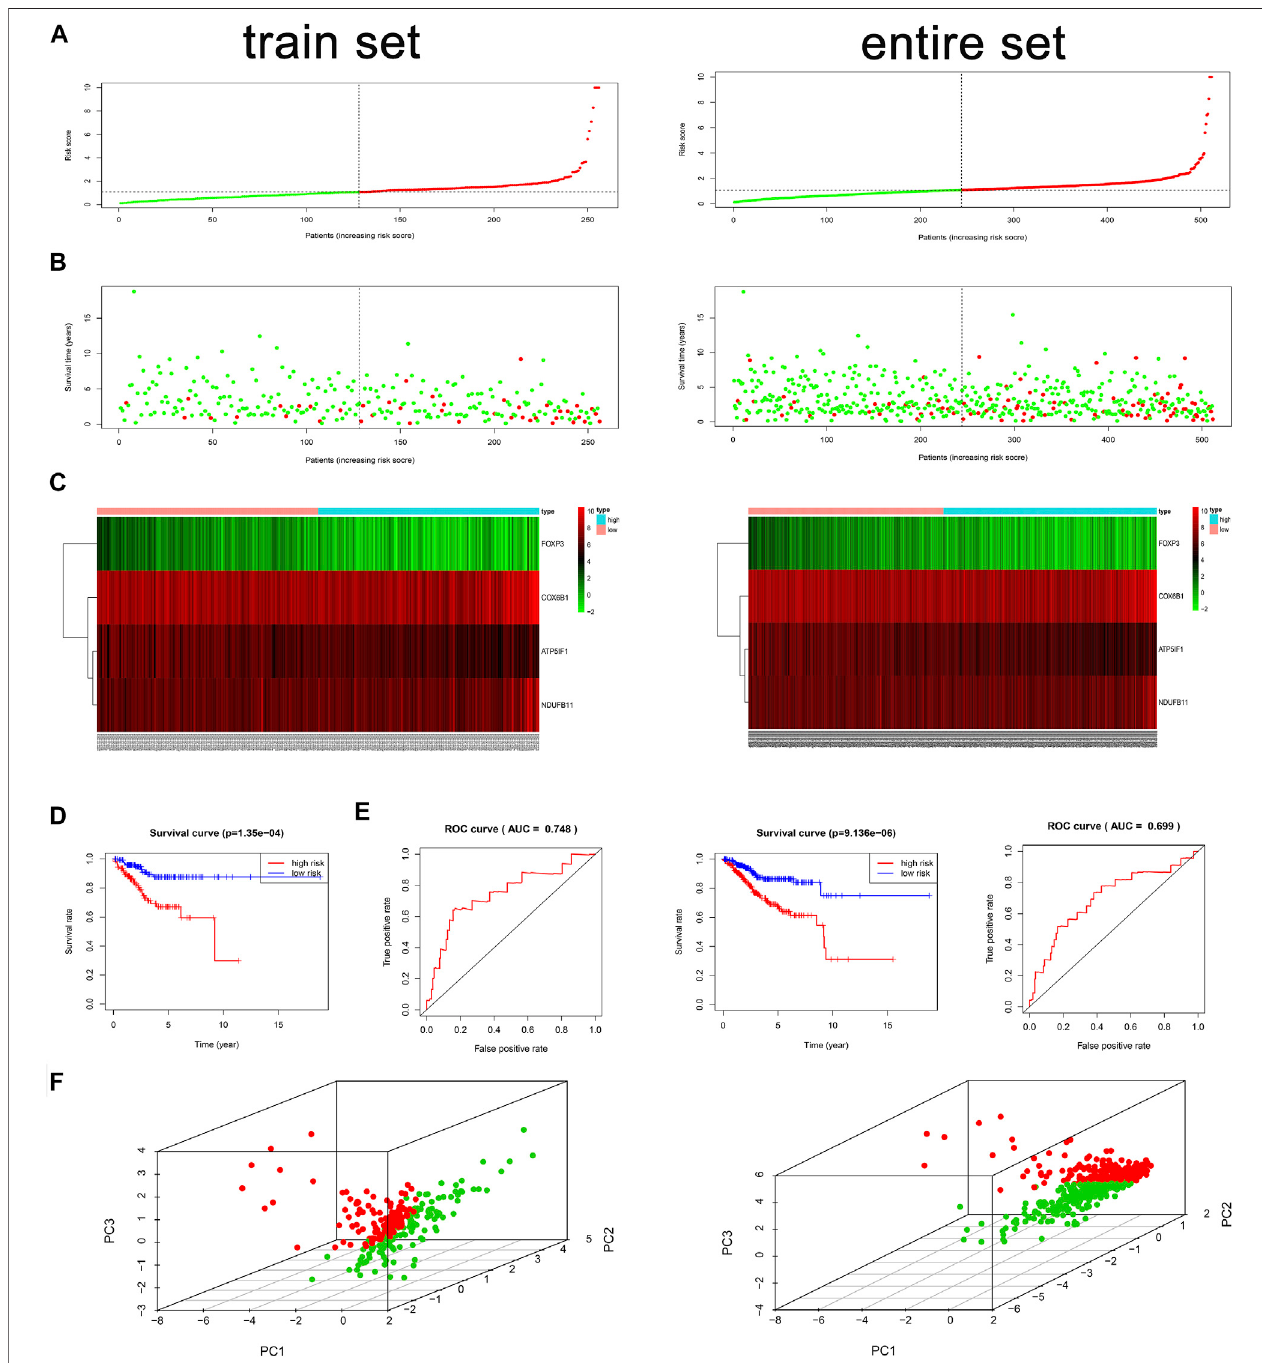
FIGURE 2 | Risk score analysis, time-dependent ROC analysis, Kaplan – Meier analysis, and PCA plots for the validation of the oxidative phosphorylation (OXPHOS)-relatedprognosticsignatureinthetrainandentiresetsbasedonoverallsurvival(OS). (A) Rankofriskscoreanddistributionofgroupsbasedonthesignature. Patients in each group were divided into the high- or low-risk groups. (B) Survival status of patients in each group. (C) Heatmap of expression pro fi les of selected four OXPHOS-related prognostic differentially expressed genes (DEGs). (D) Kaplan – Meier survival curves analyses of risk score in TCGA cohort. In the train set, in the low-risk group, N (cid:1) 128; in the high-risk group, N (cid:1) 128. In theentire set, in the low-risk group, N (cid:1) 244; in thehigh-risk group, N (cid:1) 267. (E) SurvivalROC analysis ofrisk score in predicting prognoses in the train and entire sets. (F) PCA plots of the train and entire sets. In the train set, N (cid:1) 256; in the entire set, N (cid:1) 511.